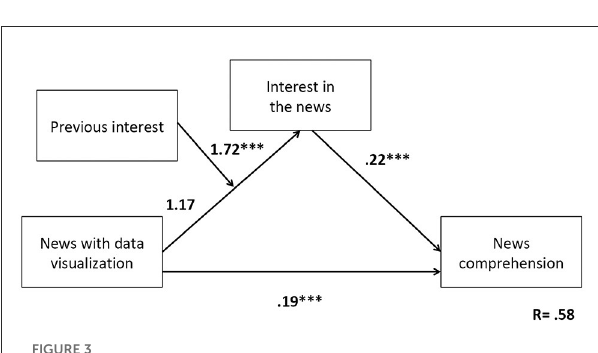
FIGURE3 Effect of previous interest. Model: independent variable—type of news; mediating variable—interest in the news; moderating variable—previous attitudes; dependent variable—comprehension. *** p < 0.001.